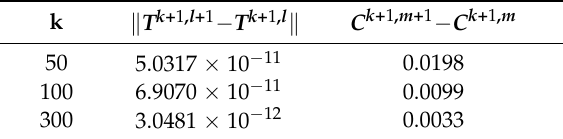
Figure 3. Concentration profiles for different spatial grid size n x and n y of Case 1. Table 2. Error estimates for various values of k , Case 2.